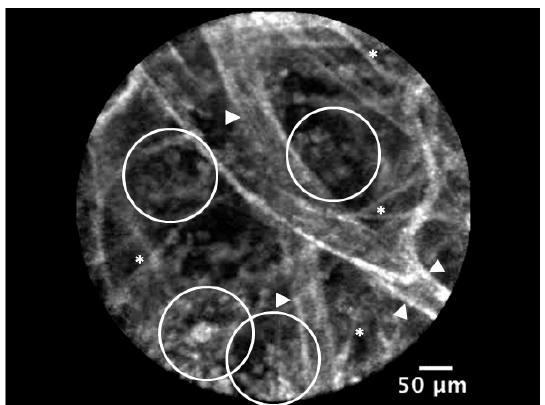
Figure 1. Video capture from a lung endomicroscopy in a patient intubated for a severe community- acquired pneumonia (see Supplementray Materials). Endogenous autofluorescence of distal airspace tissues. The identifiable structures are: numerous infiltrating free cells (presumably polymorphonuclear neutrophils (PMNs) and alveolar macrophages; empty white circles), alveolar micro-vessels (white arrows), septal walls (white asterisks). Cellvizio™ 488 (clinical-grade) (Mauna- Kea Tech.) imaging.